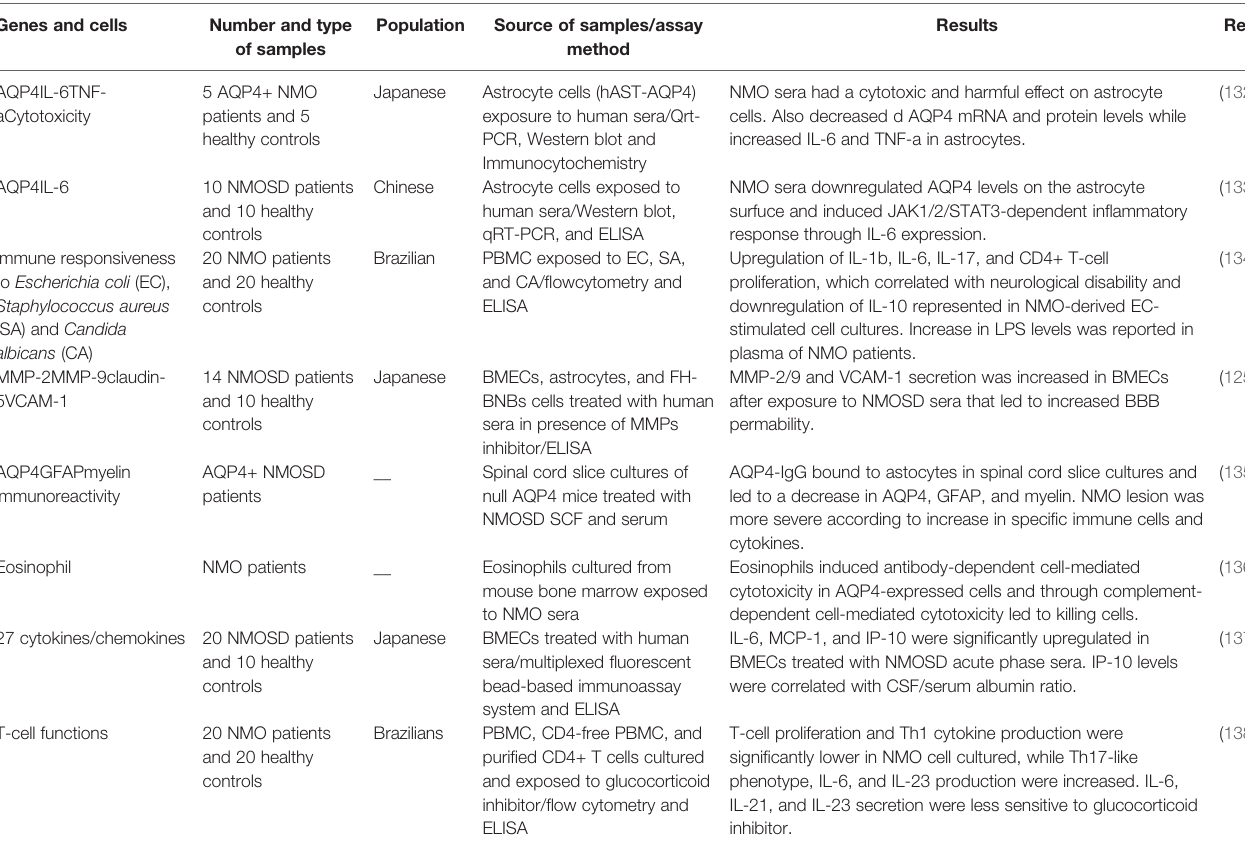
TABLE 5 | In vitro studies (BMECs, brain microvascular endothelial